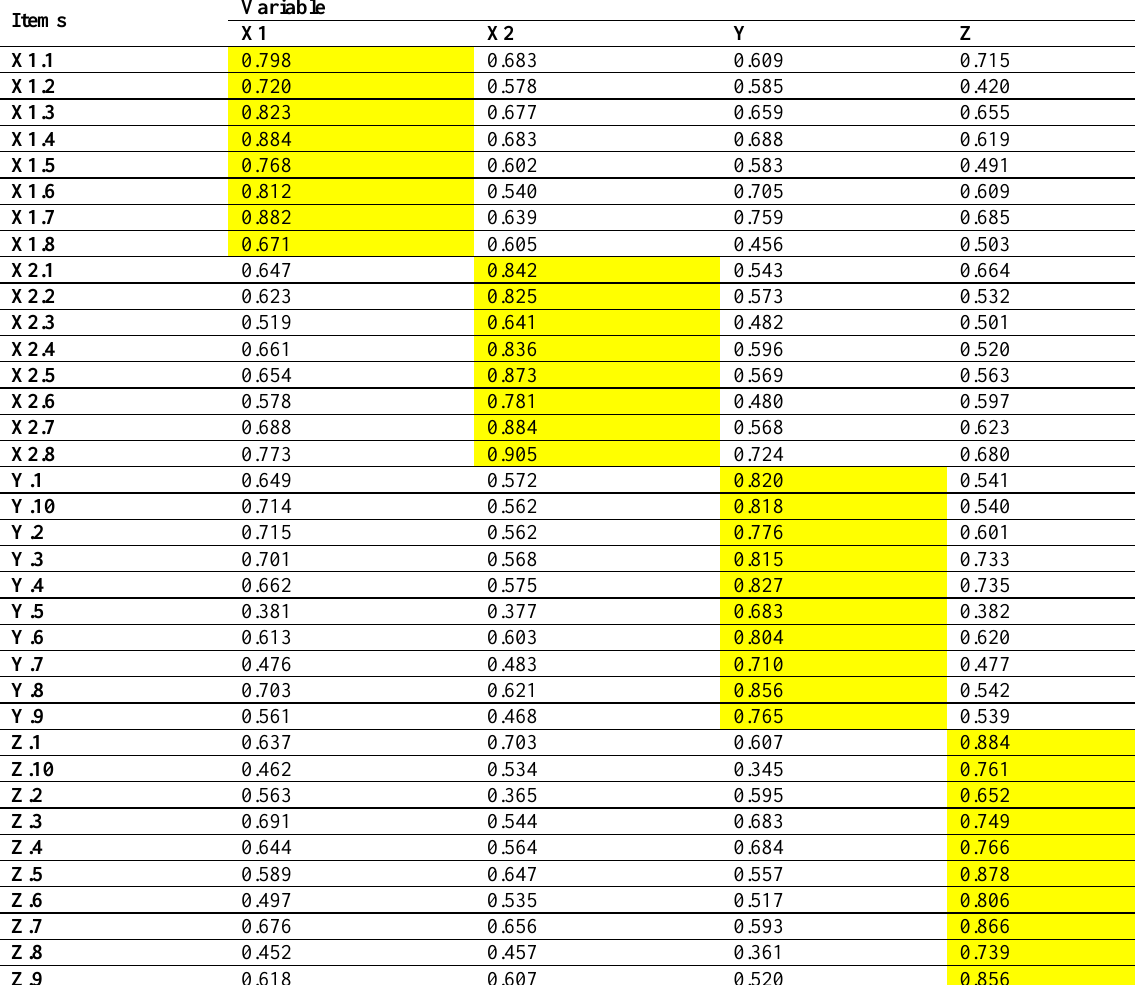
Table 3: Results of Discriminant Validity (Cross Loading)